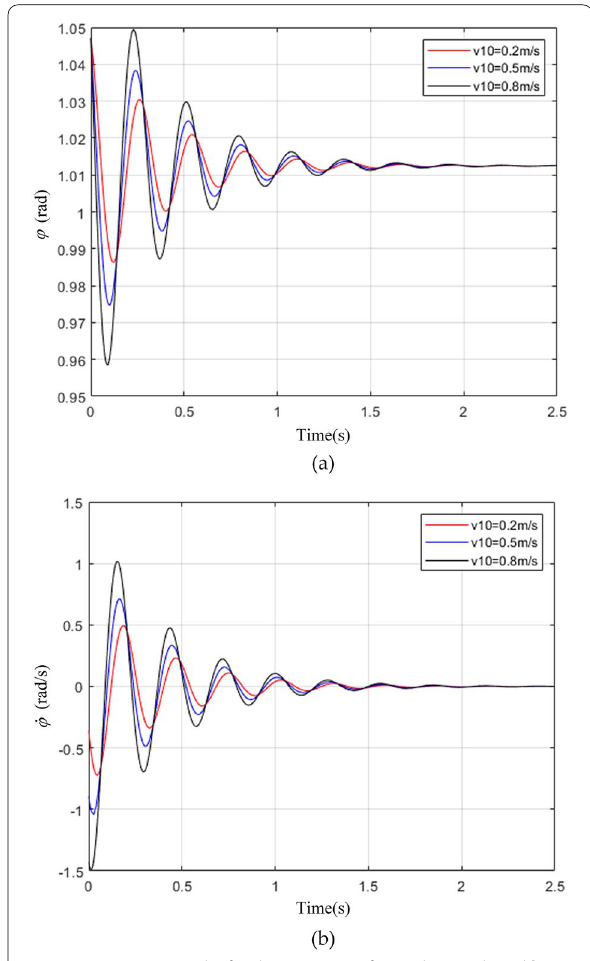
Figure 16 ATLAB results for the variation of a angle ϕ (rad) and b angular velocity ˙ ϕ 0 (rad/s) in the first-stage buffer system